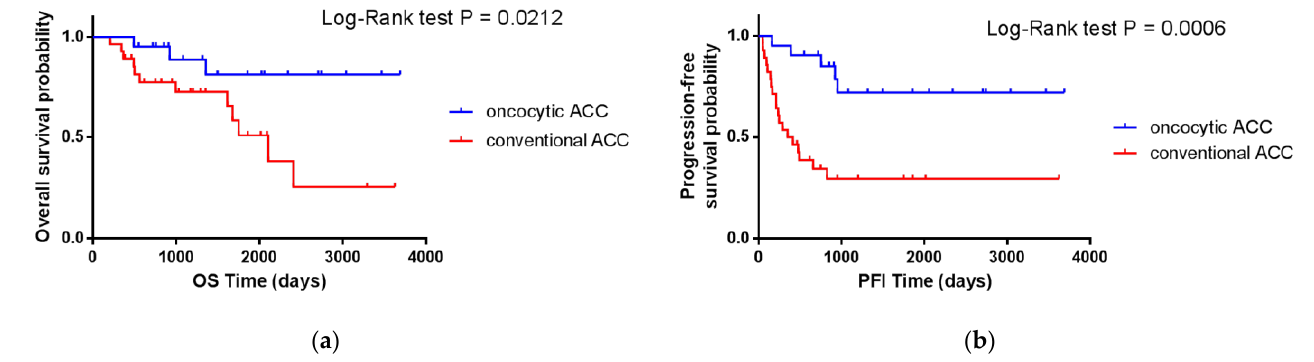
Figure 2. Overall ( a ) and progression-free ( b ) survival of conventional and oncocytic ACC patients from the TCGA cohort.